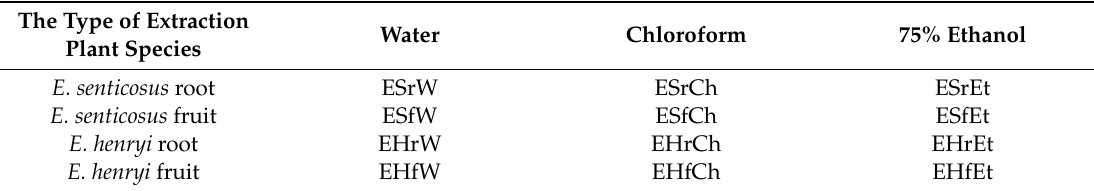
Table 2. Designation of research groups under screening for the best method of obtaining the Eleutherococcus extract (acronyms are defined in Supplementary Materials Table S2).